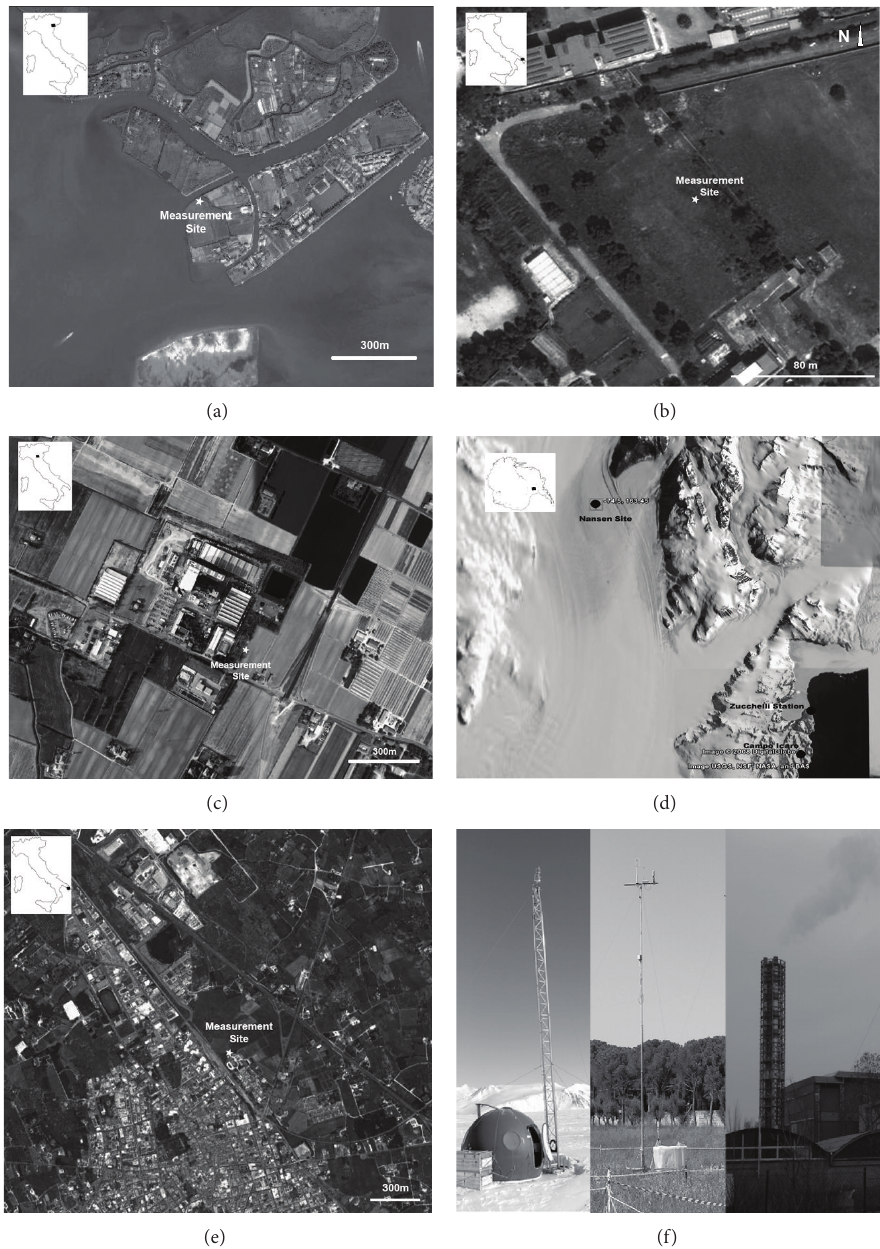
Figure 1: Maps from Google Earth © for each measurement site. In order: (a) Venice lagoon, Mazzorbo island; (b) Lecce, University Campus; (c) Bologna, Frullo industrial district; (d) Antarctica, Nansen Ice Sheet; and (e) Maglie, suburban area. In (f) a series of the measurement setup images from the different sites, in particular Antarctica tower, a micrometeorological mast in Lecce, and the incinerator chimney in Frullo